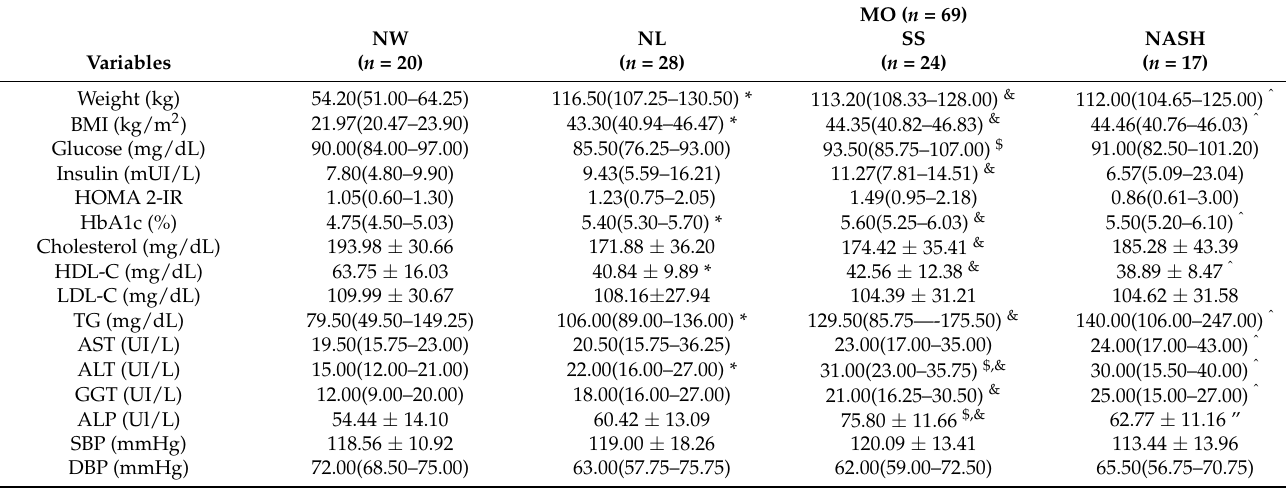
Table 1. Anthropometric and biochemical variables of women in the studied